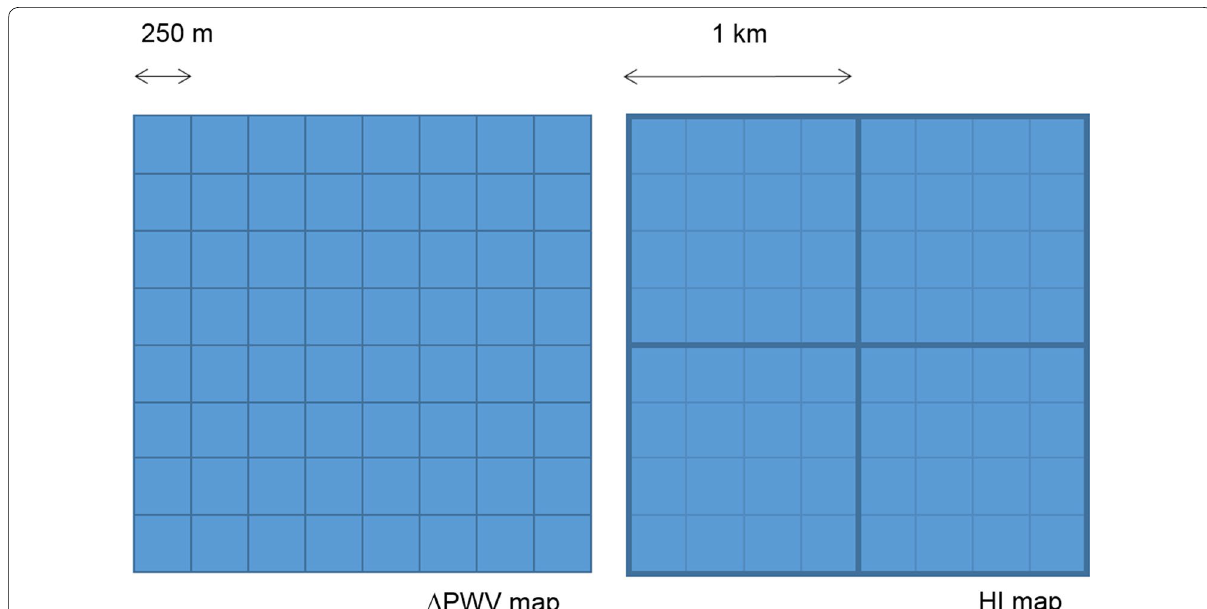
Fig. 10 Representation of the computational heterogeneity index (HI) grid with respect to the ΔPWV